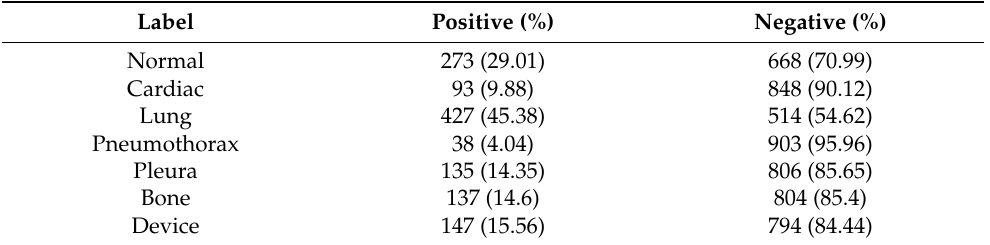
Table 2. Absolute frequencies of positive, uncertain, and negative samples for each finding (relative frequencies are reported in parentheses) in the HUM-CXR dataset ( n =